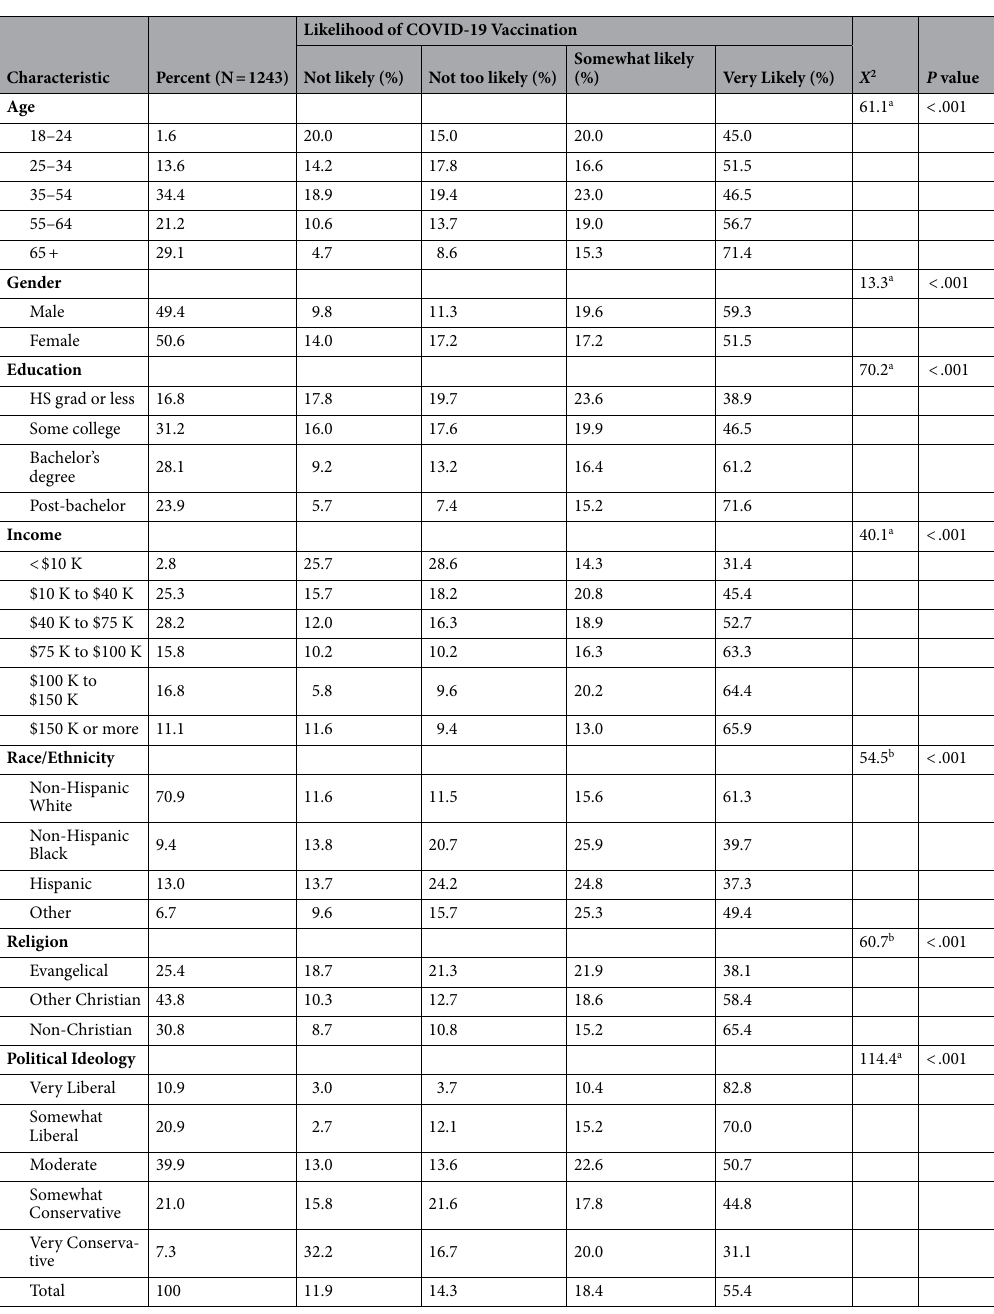
Table 1. Demographic composition of the sample in 2021 and reported likelihood of COVID-19 vaccination with X 2 tests of relationshjp. X 2 tests denoted with a refer to linear relations, while those with b are tests for categorical